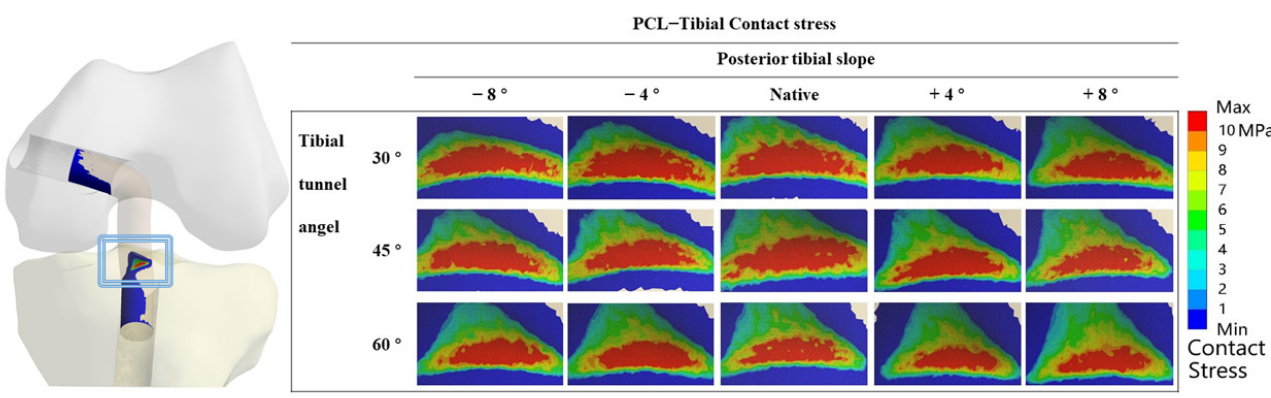
Figure 4. Contact stress distribution around the tibial tunnel entrance following PCL reconstruction.